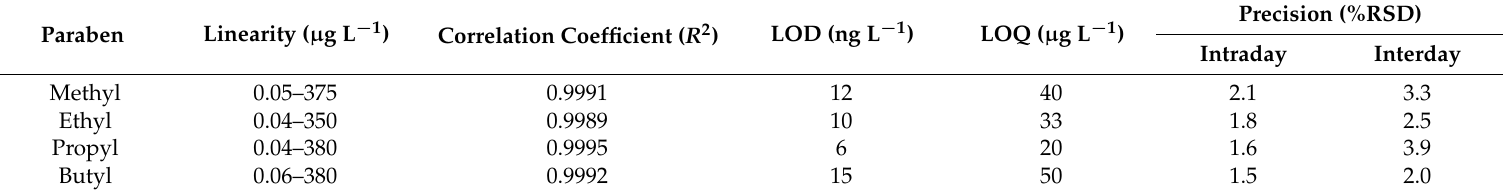
Table 3. Analytical figures of merit of the proposed in-syringe MSPE/HPLC method for the preconcentration and determination of parabens.